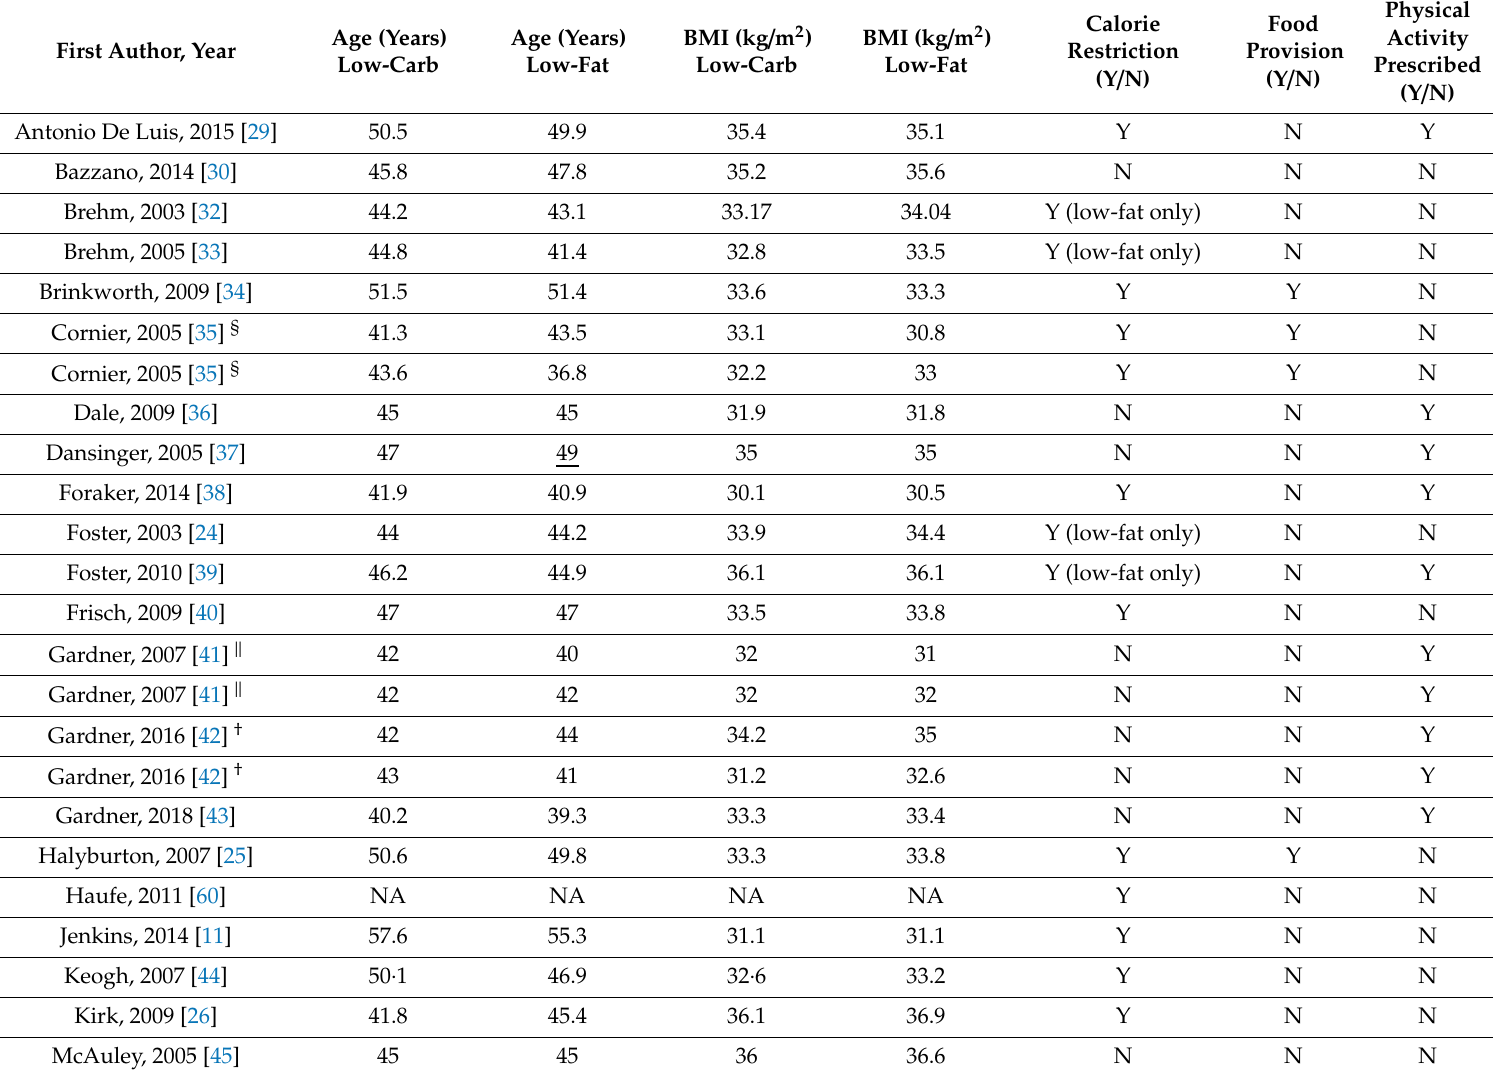
Table 2. Age, BMI, presence of calorie restriction, food provision, and exercise for all of the included